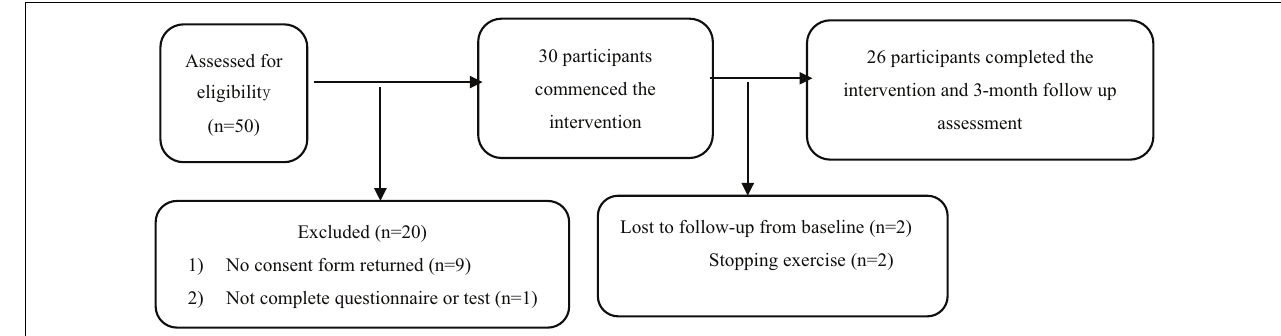
FIGURE 1 | Consolidated standards of reporting trials